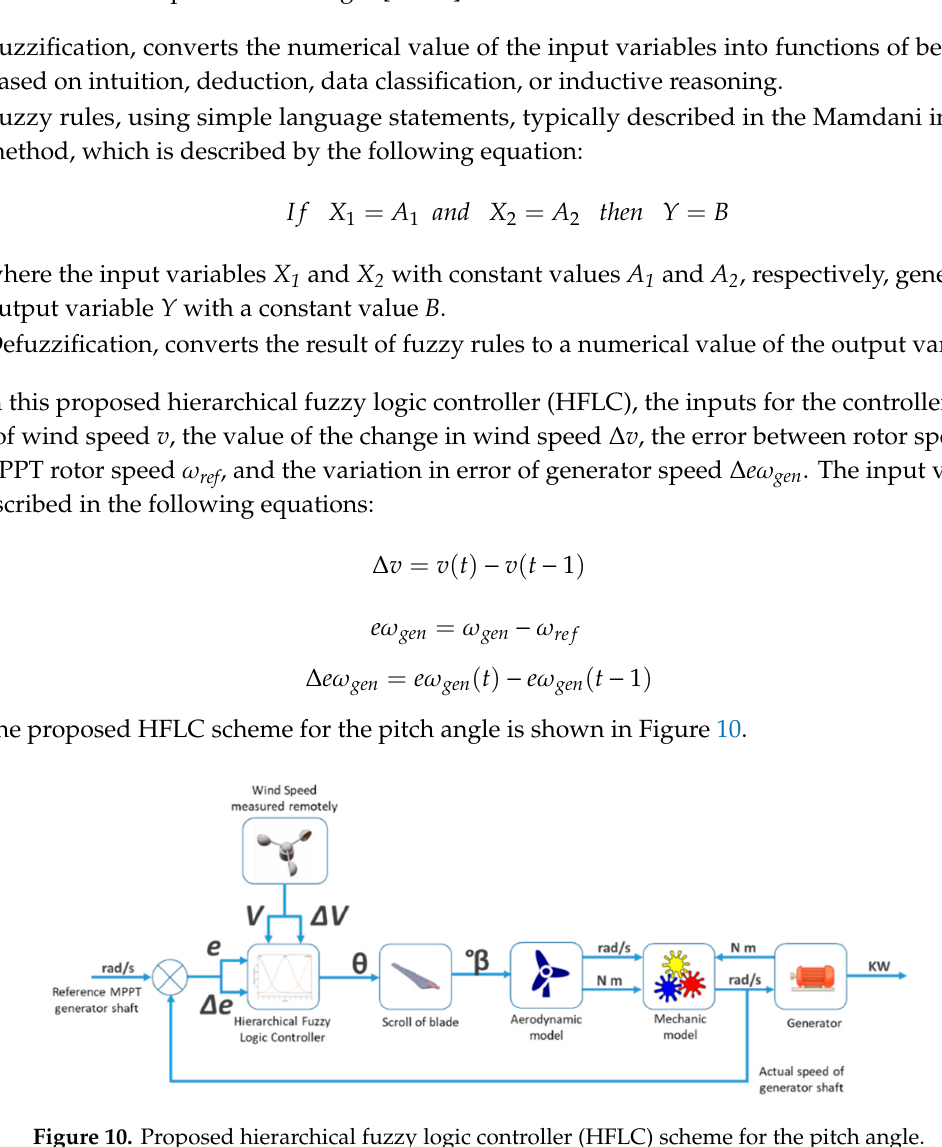
Figure 11. Membership functions for wind speed. Second level. According to the magnitude of the change in wind speed. In region 2 and 3, it is important to consider changes in wind speed, as an abrupt change can accelerate the rotor and cause current spikes, saturate the generator, or physically damage the wind turbine. When a change in wind speed is detected in the anemometer at 450 m, the pitch angle moves in advance depending on the